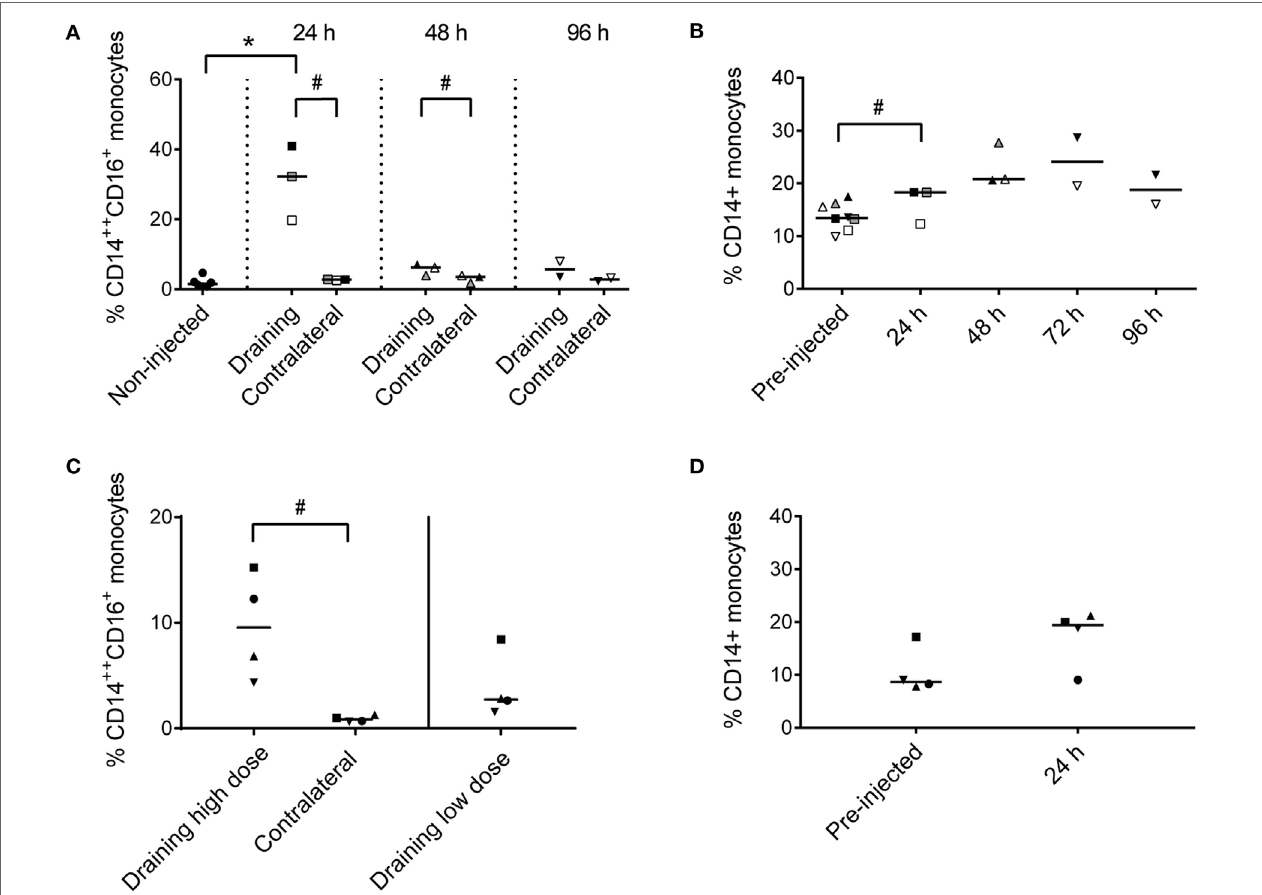
FigUre 4 | Percentages of monocytes in lns and PBMc . (a) Percentages of CD14 ++ CD16 + monocytes of total live cells in LNs of non-injected animals, and in draining and contralateral LNs of injected animals at 24, 48, and 96 h post-injection. Symbols represent individual animals and the median value within each group is depicted as a line. Statistical significant differences between injected and non-injected groups using the Wilcoxon rank-sum test are indicated as * P < 0.05. Statistical significant differences between groups consisting of the same individuals (identical symbols) using the paired t -test are indicated as # P < 0.05. (B) Percentage of CD14 + monocytes of live cells in PBMC at pre-injection, and at 24, 48, 72, and 96 h post-injection. Symbols and statistics as in (a) ( # P < 0.05). (c) Percentage of CD14 ++ CD16 + monocytes of live cells in the draining high dose (subiliac) LN and the contralateral LN, and in the draining low-dose (superficial cervical) LN. Symbols and statistics as in A ( # P < 0.05). (D) Percentage of CD14 + monocytes of total live cells in PBMC at pre-injection and after 24 h. Symbols and statistics as in